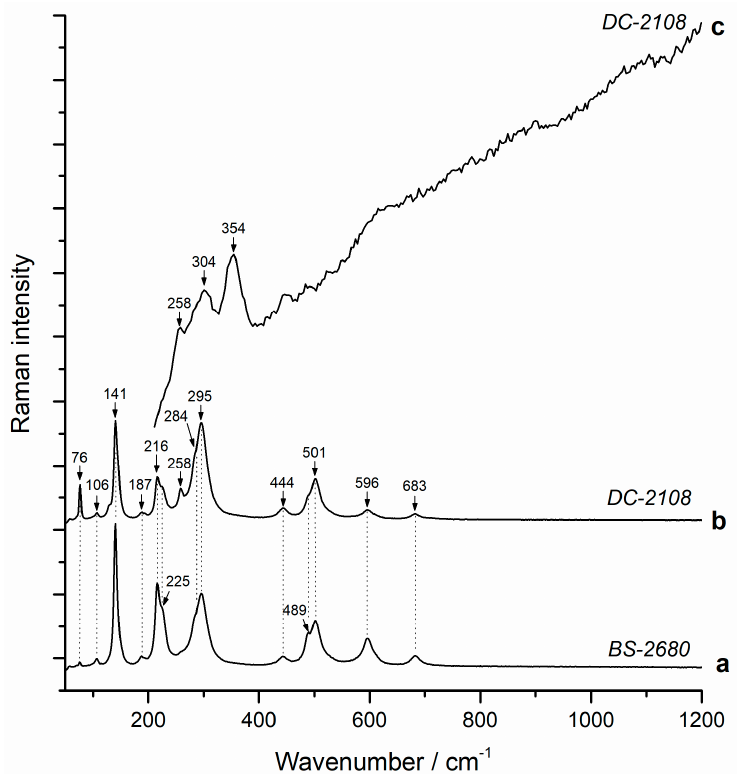
Figure 4. Raman spectra of valentinite samples from Baia Sprie ( a ) and Dealul Crucii ( b ); Raman spectrum of colloform sphalerite ( c ).